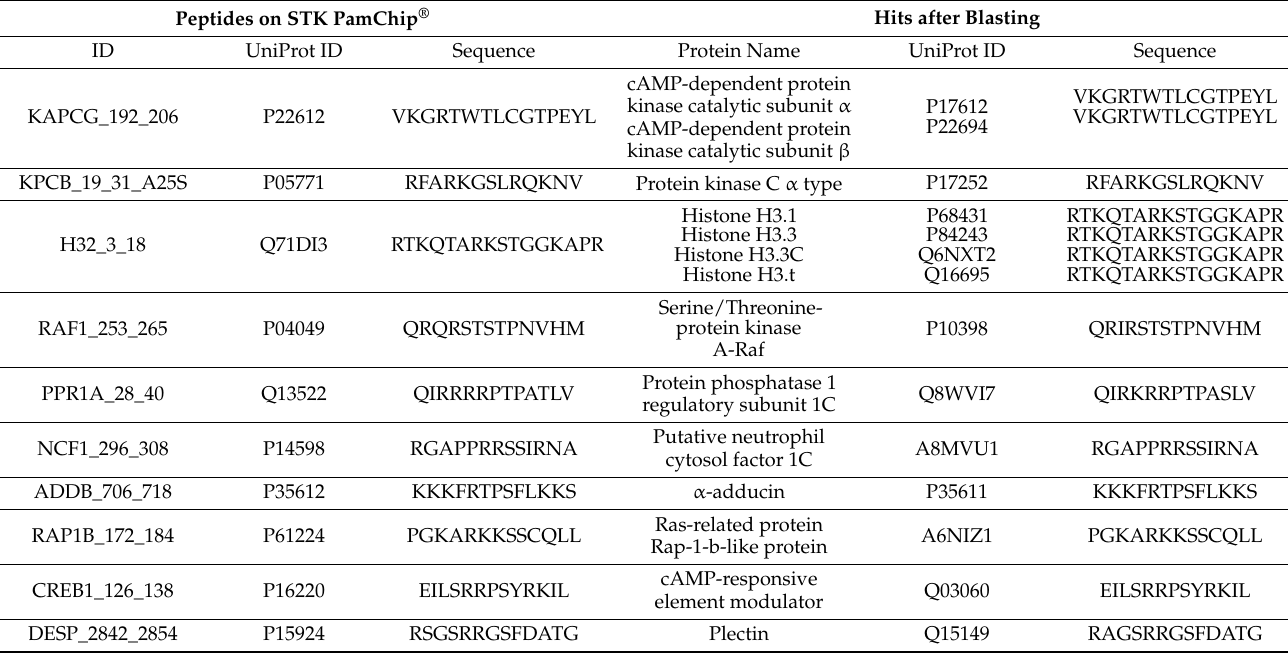
Table 3. Proteins phosphorylated by PKGI and or PKGII, (similarity = 1) after blasting of the peptides in Table 2. Peptides on STK PamChip